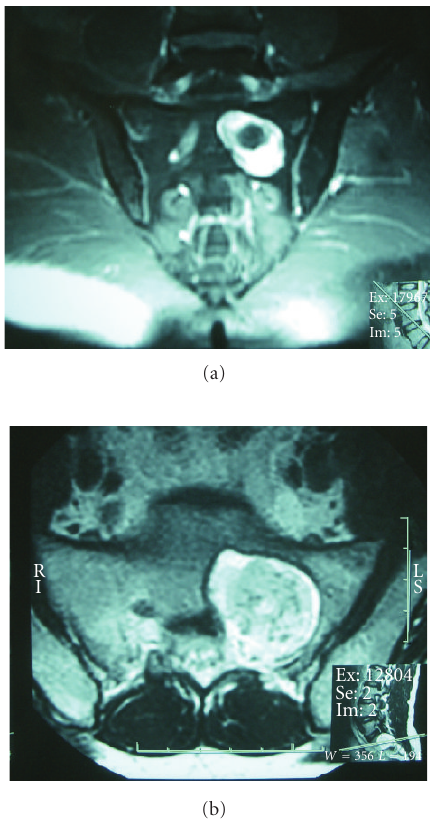
Figure 4: Coronal (Figure 4(a)) and axial (Figure 4(b)) T2- weighted MR images show tumor with heterogeneous signal intensity involving left S1 foramen.